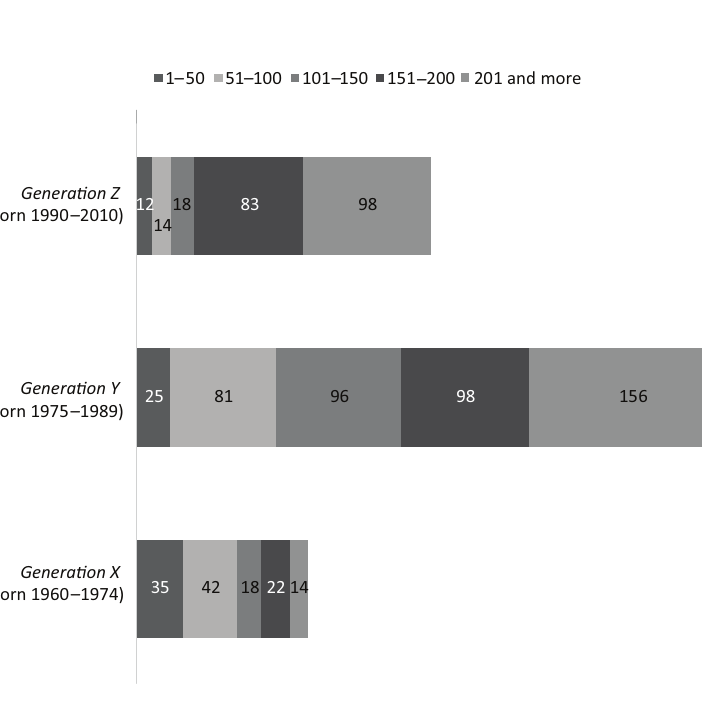
fig. 3. Age (generation) share, N = 812